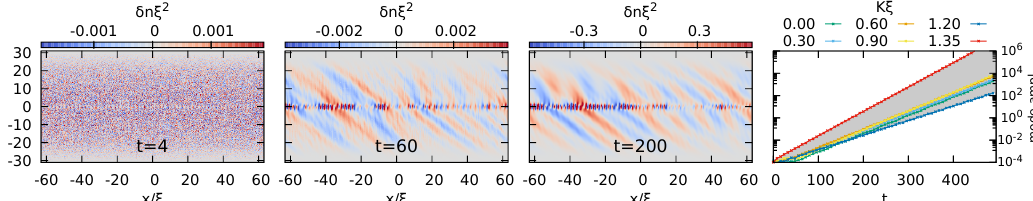
Figure 6: First three panels: snapshots of the time evolution of the density variations obtained by evolving in time the Bogoliubov equations for ∆ v = 3 c noisy configuration. Two absorbing regions with a Gaussian spatial profile around ± L / 2 are included to simulate an infinite system. The growing unstable modes is y composed by waves travelling along the array of vortices and outgoing sound waves. Times are expressed in units of ħ h /µ . A video of this evolution is available online [ 25 ] . Last panel: log-plot of the amplitude of some wavenumber components of the growing perturbations; one can see the exponential growth. The gray area indicates the interval between the lowest and the highest fitted